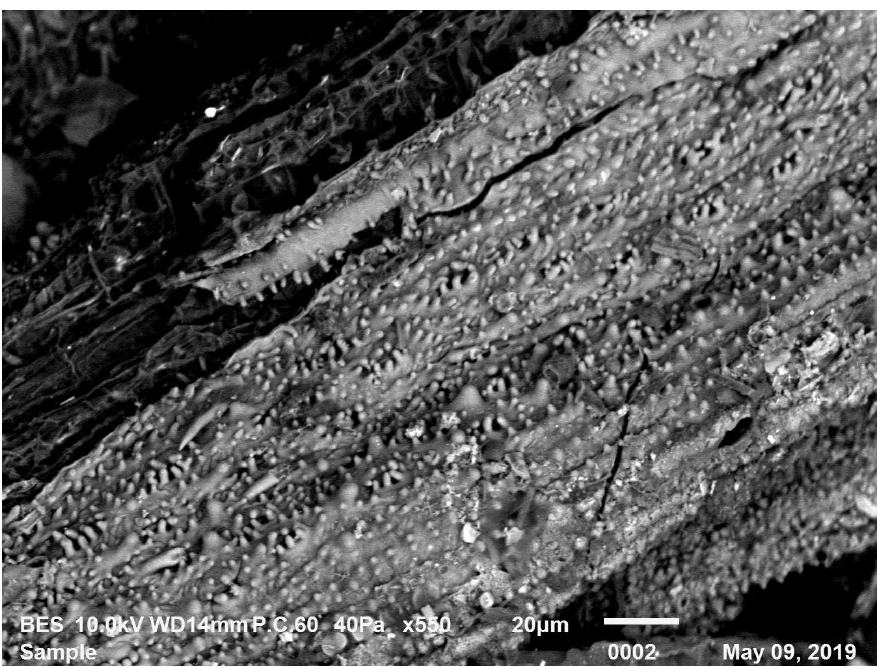
Figure 1. Activated rice straw biochar physiological morphology at ×550 under SEM. Table 2. Selected physico-chemical properties of rice straw and rice straw biochar.